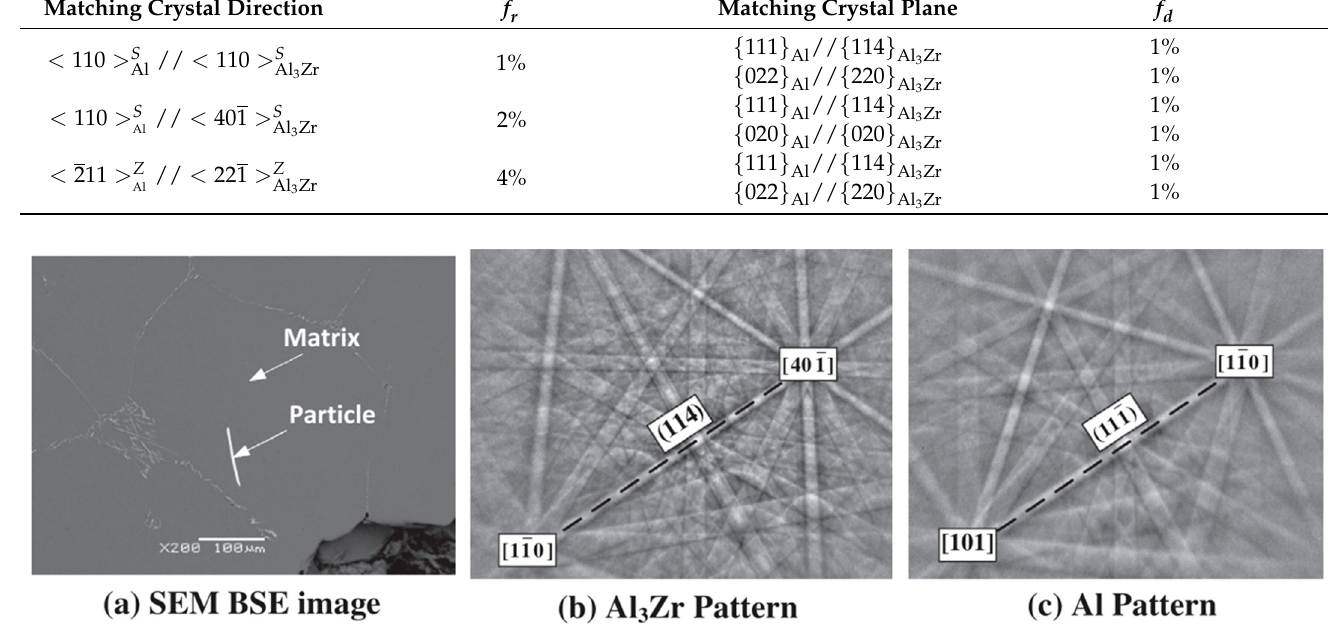
Figure 5. Backsca tt ered electronic (BSE) image of the microstructure and EBSD Kikuchi pa tt ern of Figure 5. Backscattered electronic (BSE) image of the microstructure and EBSD Kikuchi pattern of Al 3 Zr and Al [28]. Reprinted with permission from [28], 2013, Elsevier. Al 3 Zr and Al [28]. Reprinted with permission from [28], 2013, Elsevier. The grain refinement mechanisms of solute atom Zr and Al 3 Zr are different,